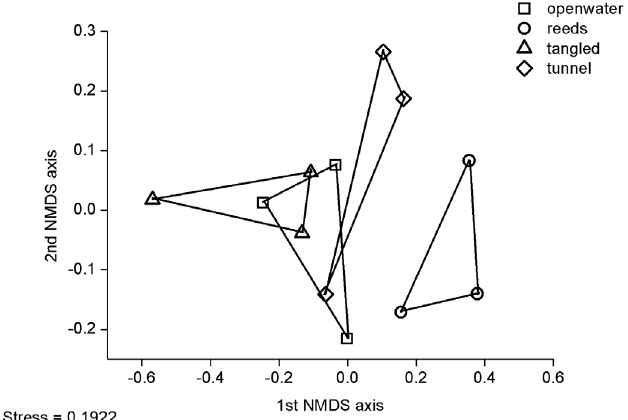
Figure 4. NMDS ordination of the plant associated Cladocera remains of vegetation types (stress=0.1922).